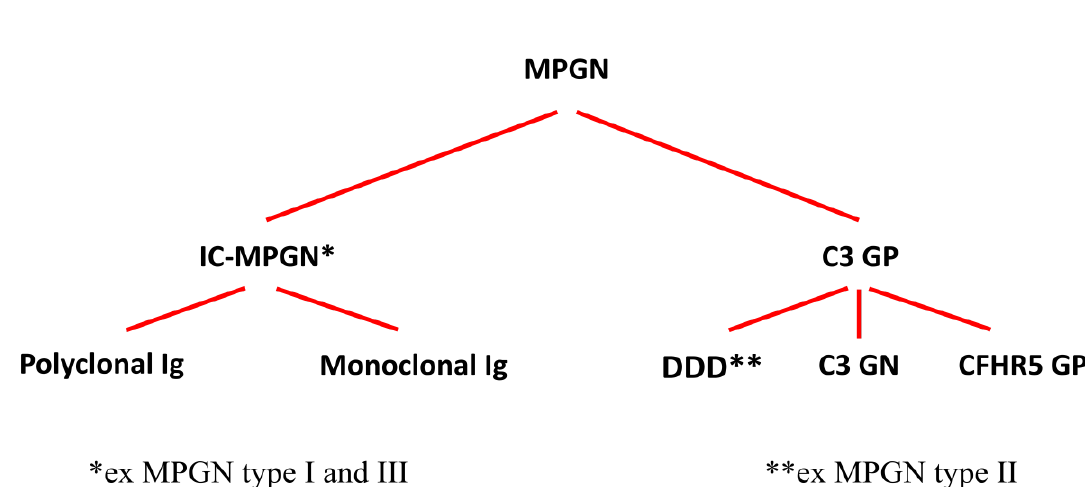
Figure 1. Classification of the membranoproliferative glomerulonephritis (MPGN). Abbreviations: IC-MPGN (immune complex MPGN); Ig (immunoglobulin); C3 GP (C3 glomerulopathy); DDD (dense deposits disease); C3 GN (C3 glomerulonephrits); CFHR5 GP (complement factor H-related protein 5 glomerulopathy).